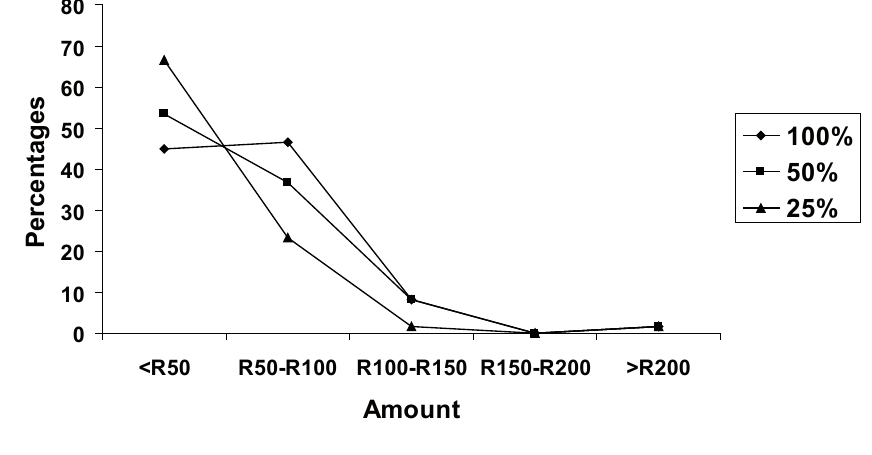
Figure 1. The willingness to pay varying amounts for different chanc- es of seeing Cape clawless otters Aonyx capensis in Dwesa Nature